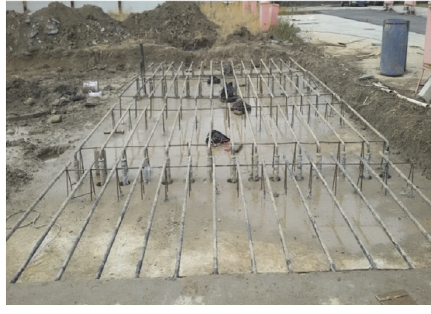
Figure 4: Full scale experimental platform.